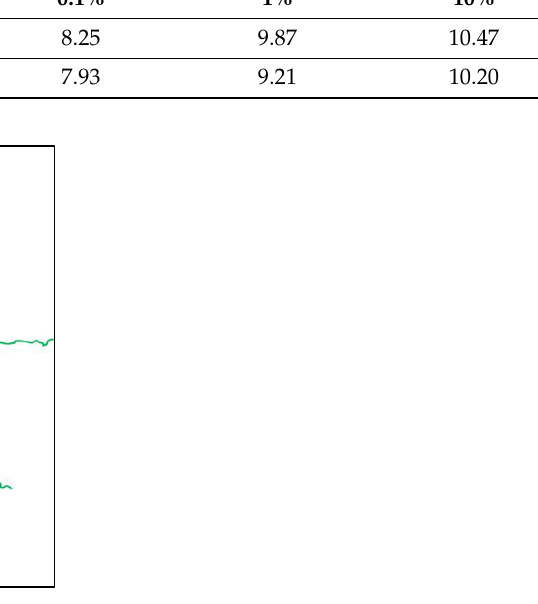
Figure 10. Proposed scheme for the particles of the inorganic phases stabilized by the acrylamide molecules. molecules.